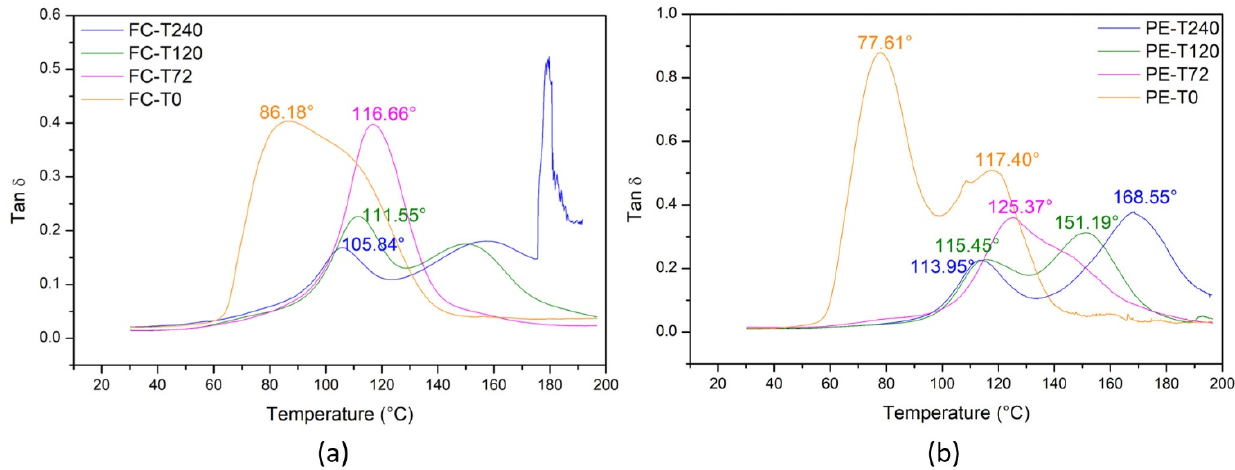
Figure 10. Effect of time aging on the loss tangent (tan δ ) curves for: ( a ) fique fabric-reinforced epoxy composites; and ( b ) plain epoxy.